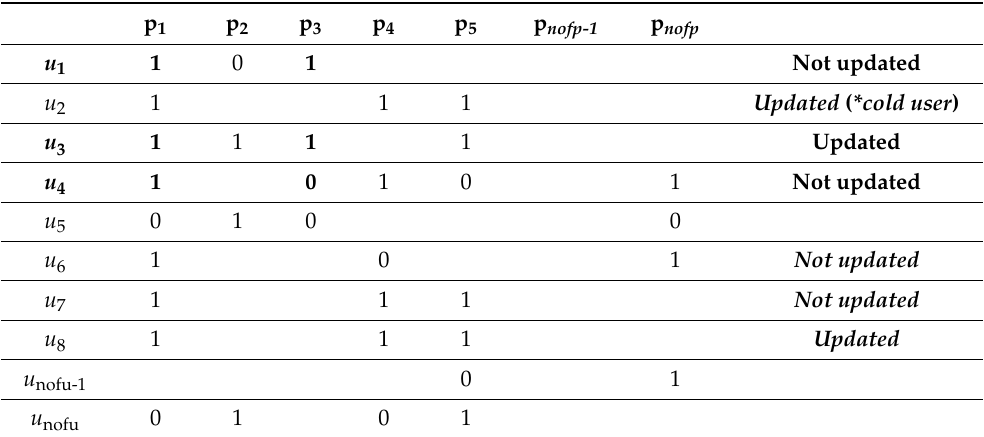
Table 2. User–product matrix